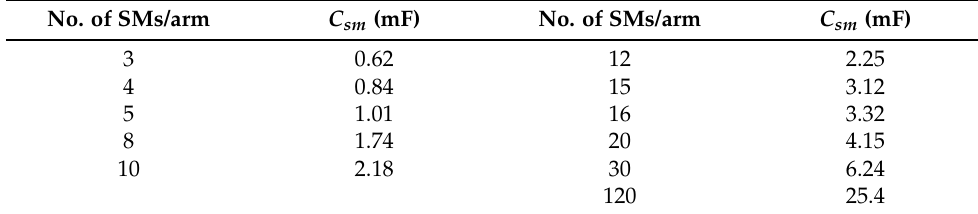
Table 3. Inner MMC component parameters.